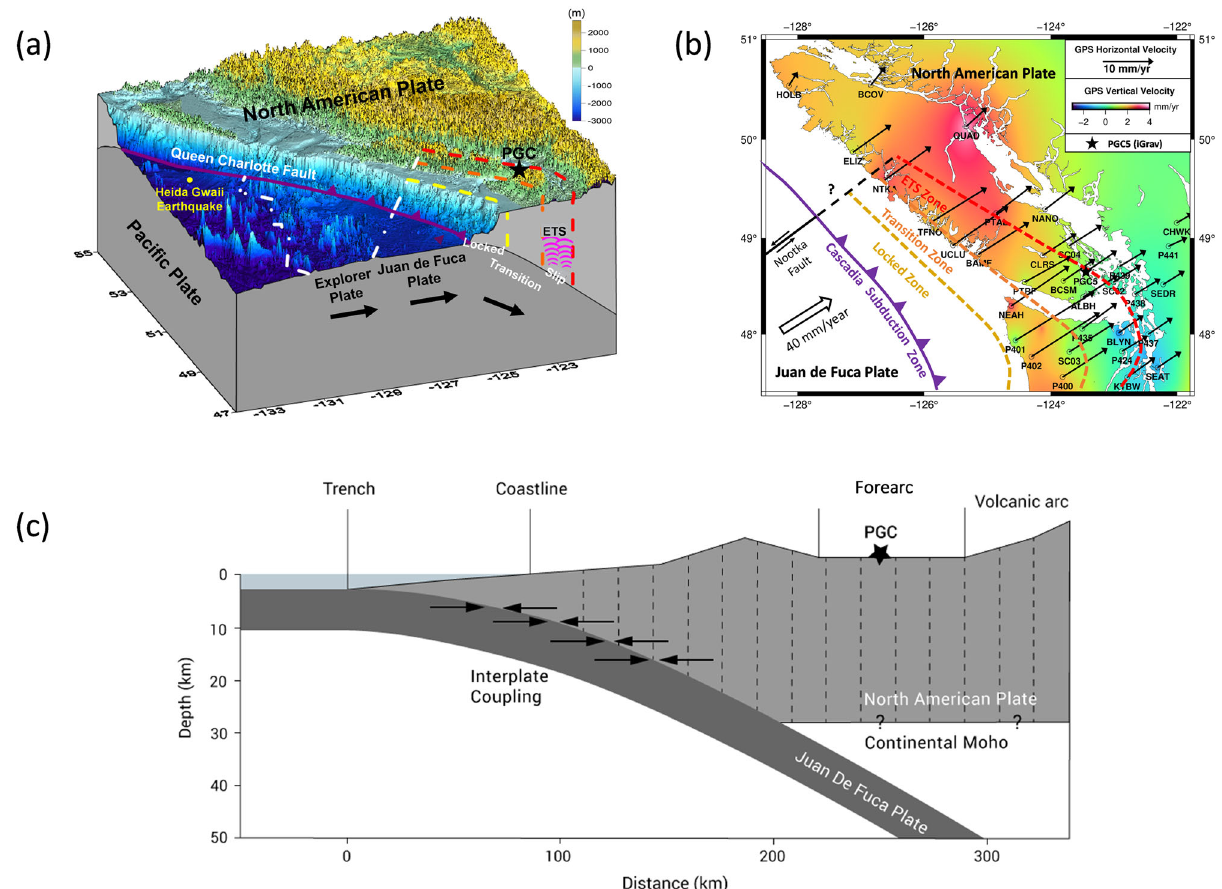
Fig. 1 Map and schematic view of the Cascadia subduction zone. a Topography and locations of the epicenter of the Haida Gwaii earthquake and the iGrav ® SG at PGC; ( b ) Velocities of the horizontal crust movement (arrow direction) and vertical crust movement (color map) interpolated from 38 GPS sites along with the surface projection of locked, transition and ETS zones 13 . The map was created by using the Generic Mapping Tools (GMT) 71 ; ( c ) Schematic cross section view of the CSZ and the location of PGC. The prisms used for gravity modelling are shown with dashed Fig. 2a with a clear increasing trend rate. The gravity signal contains a few steps occurring on October 28th 2012, and August 21st and 22nd 2013. We detected two major events on these two dates. One of the events is associated with two large offsets, with a